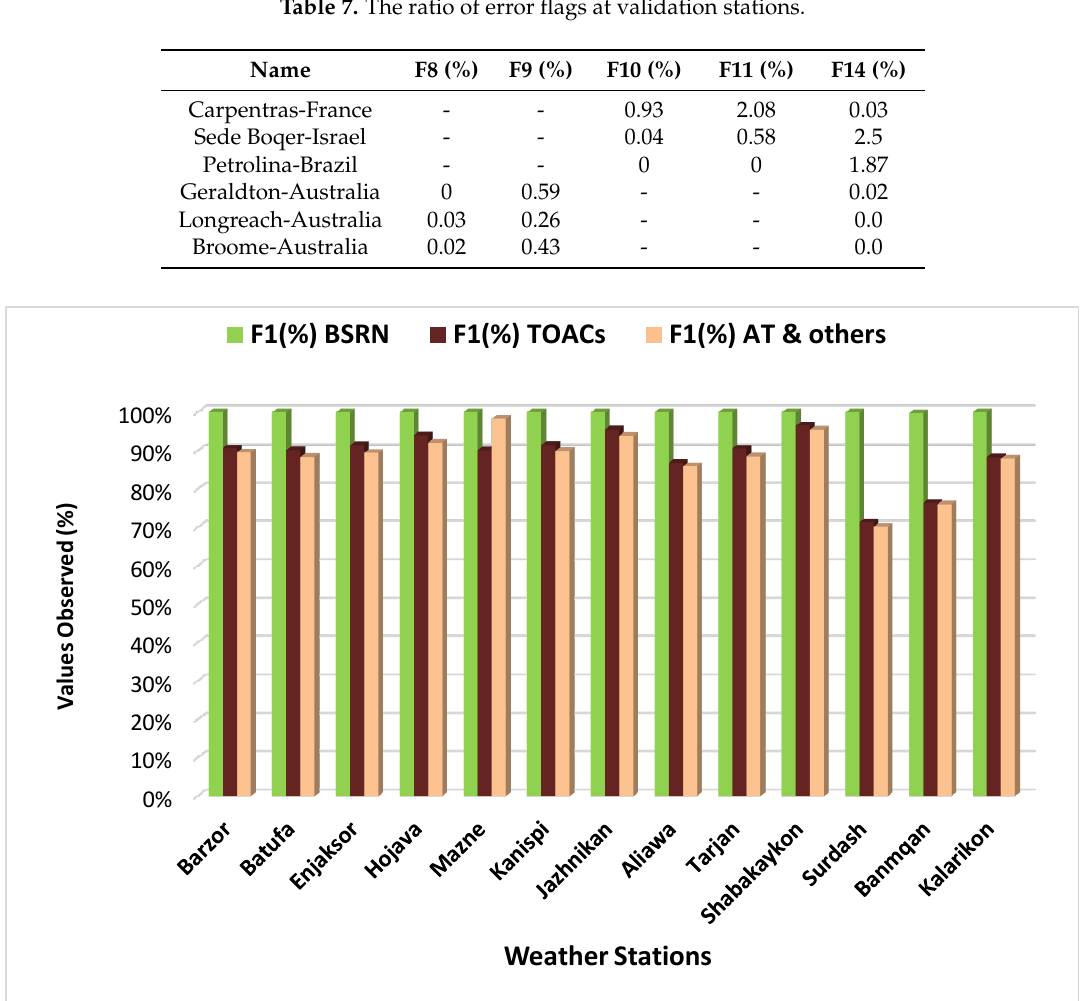
Figure 6. Bar chart of flag 1 passed data according to each set of tests in tower stations. ‘Others’ refers to previous tests such as BSRN and TOACs.